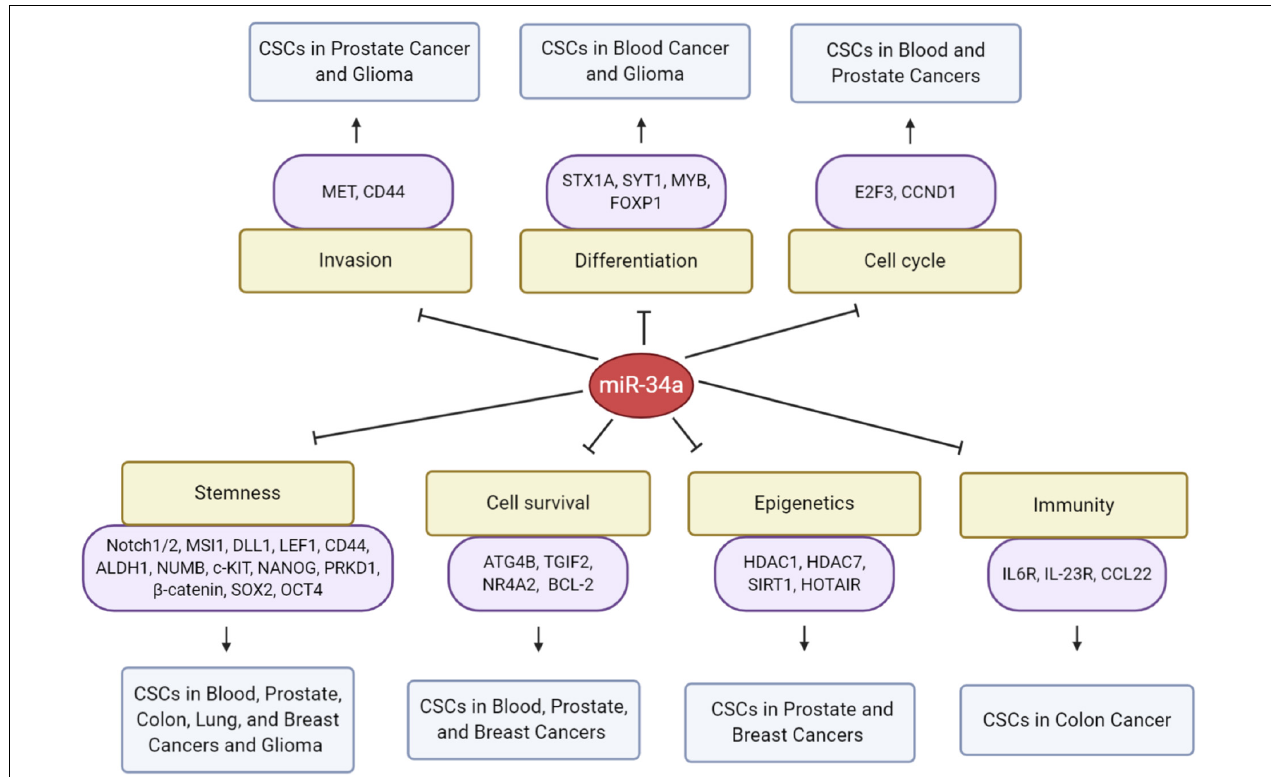
FIGURE 4 | MicroRNA-34a regulation of CSCs. Presented are direct targets of miR-34a and biological consequences on CSCs in the indicated cancer